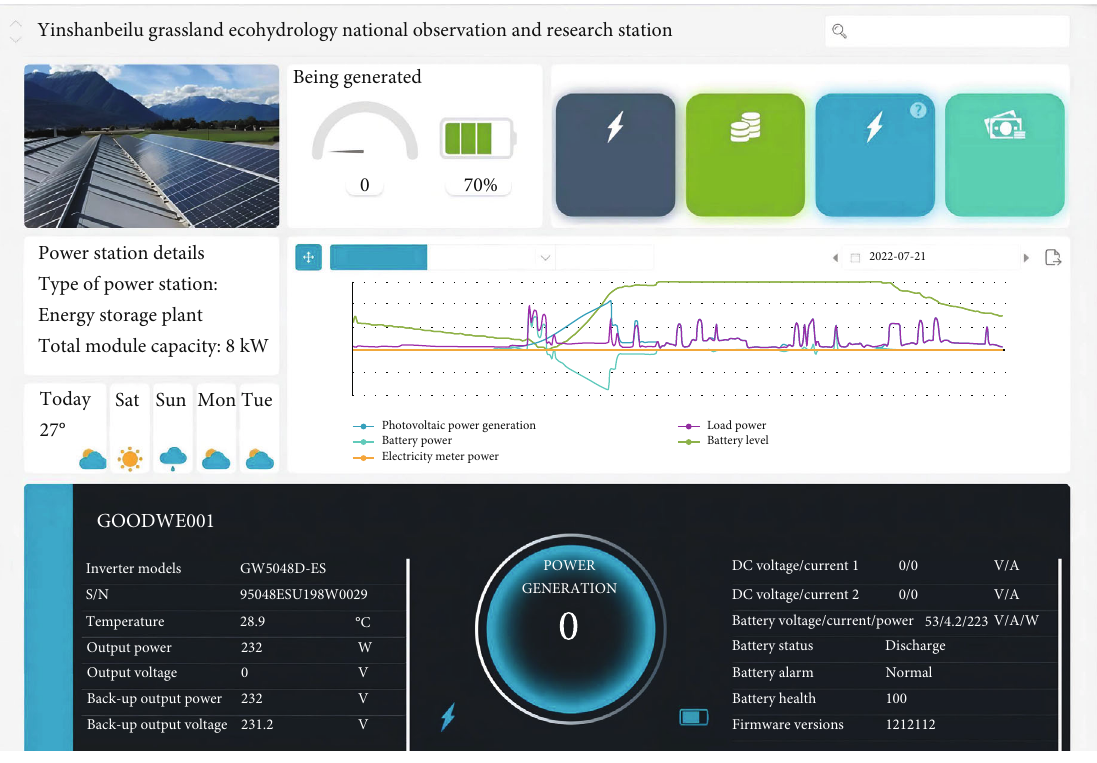
Figure 10: Monitoring platform of test data.